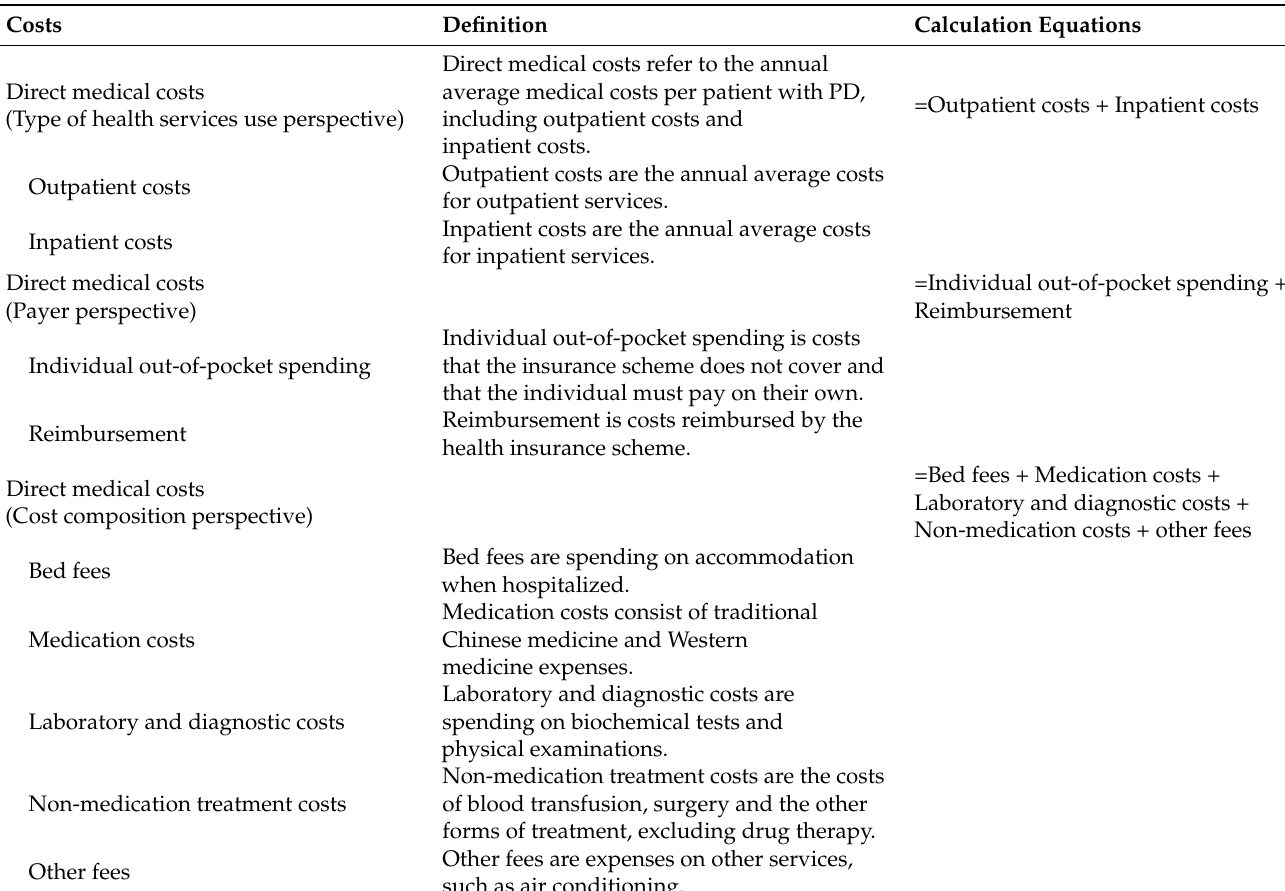
Table 2. Definitions of different classifications of direct medical